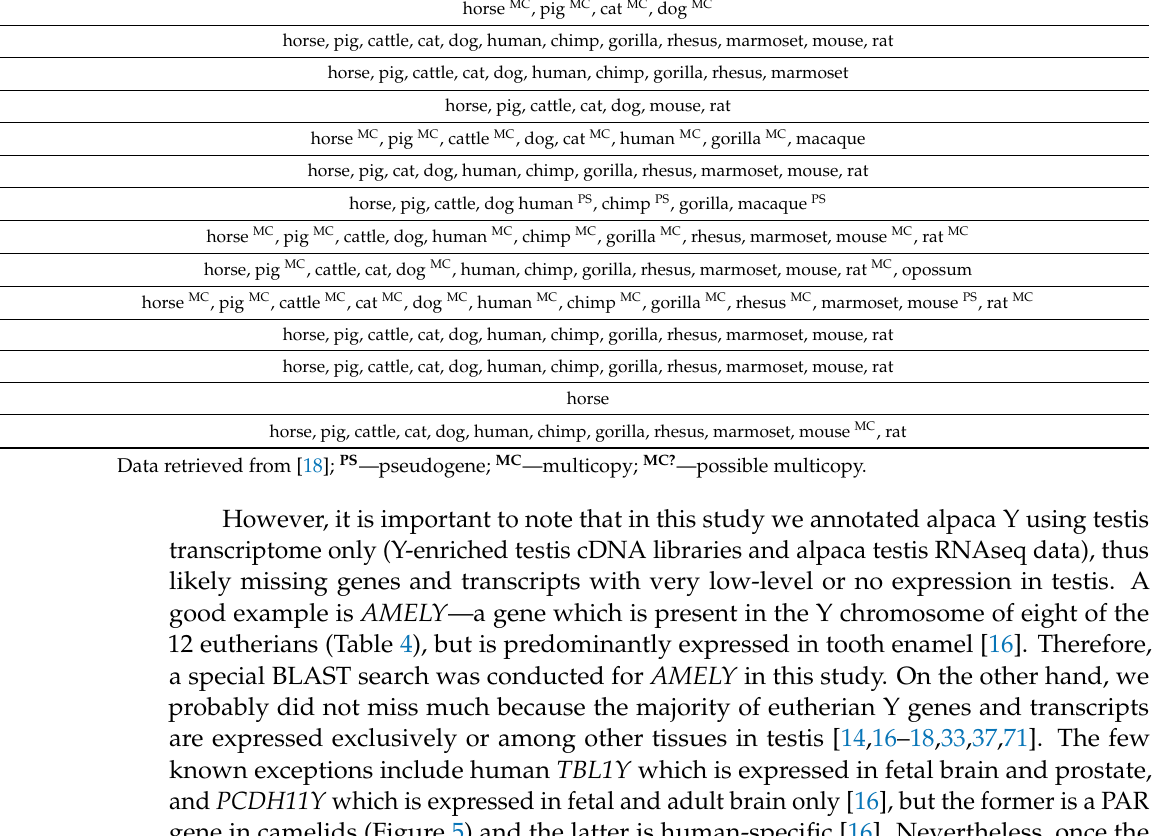
Table 4. Comparative status of 15 alpaca X-degenerate genes in 12 eutherian mammals and opossum. Alpaca Gene Presence in Other Mammals AMELY horse, pig, cattle, cat, human, chimp, gorilla,